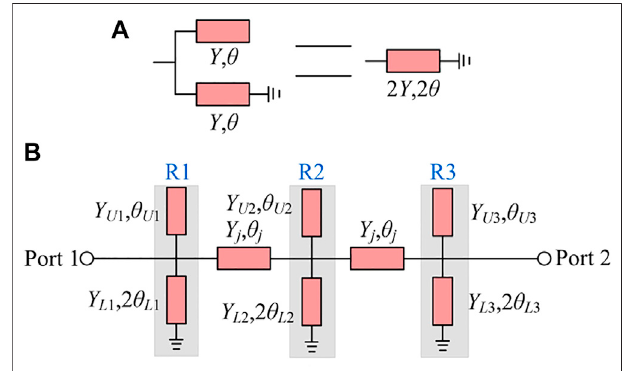
FIGURE 3 | (A) Parallel equivalent diagram of open-circuited and short- circuited branch-lines (B) TLM of a third-order dual-band fi